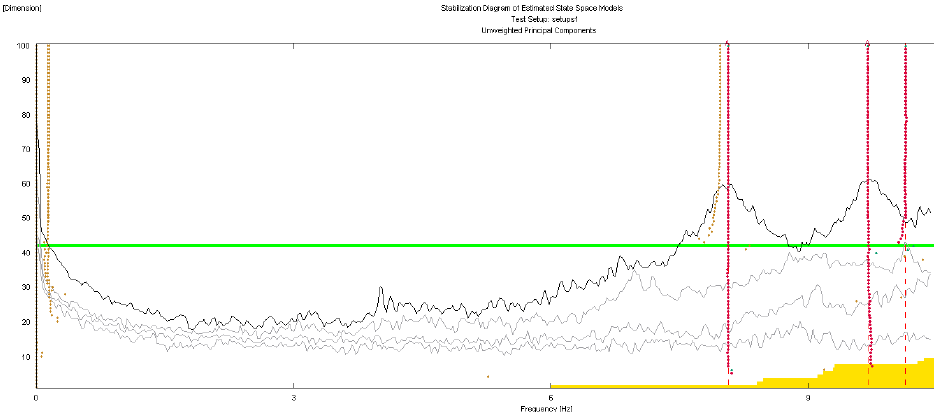
Figure 8. OMA identification with Stochastic Subspace Identification (SSI) method, Test 1. Table 1. Experimental identified frequencies (Hz) by SSI and EFDD techniques and mode shape type. STRUCTURE A.